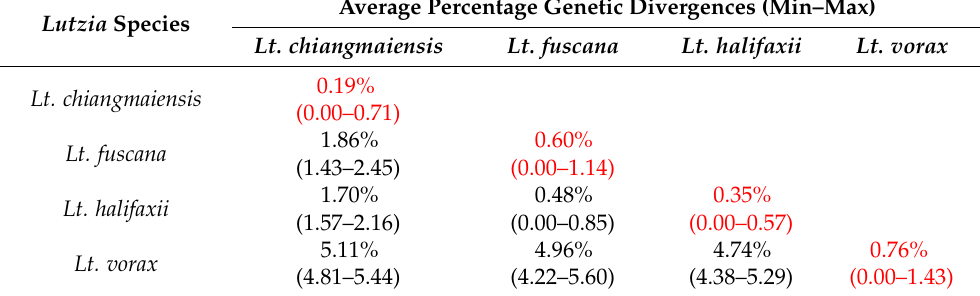
Table 4. Average percentage intra- and interspecific K2P distances of four Lutzia species based on the COI barcoding sequences calculated using the Kimura 2-parameter distance algorithm.